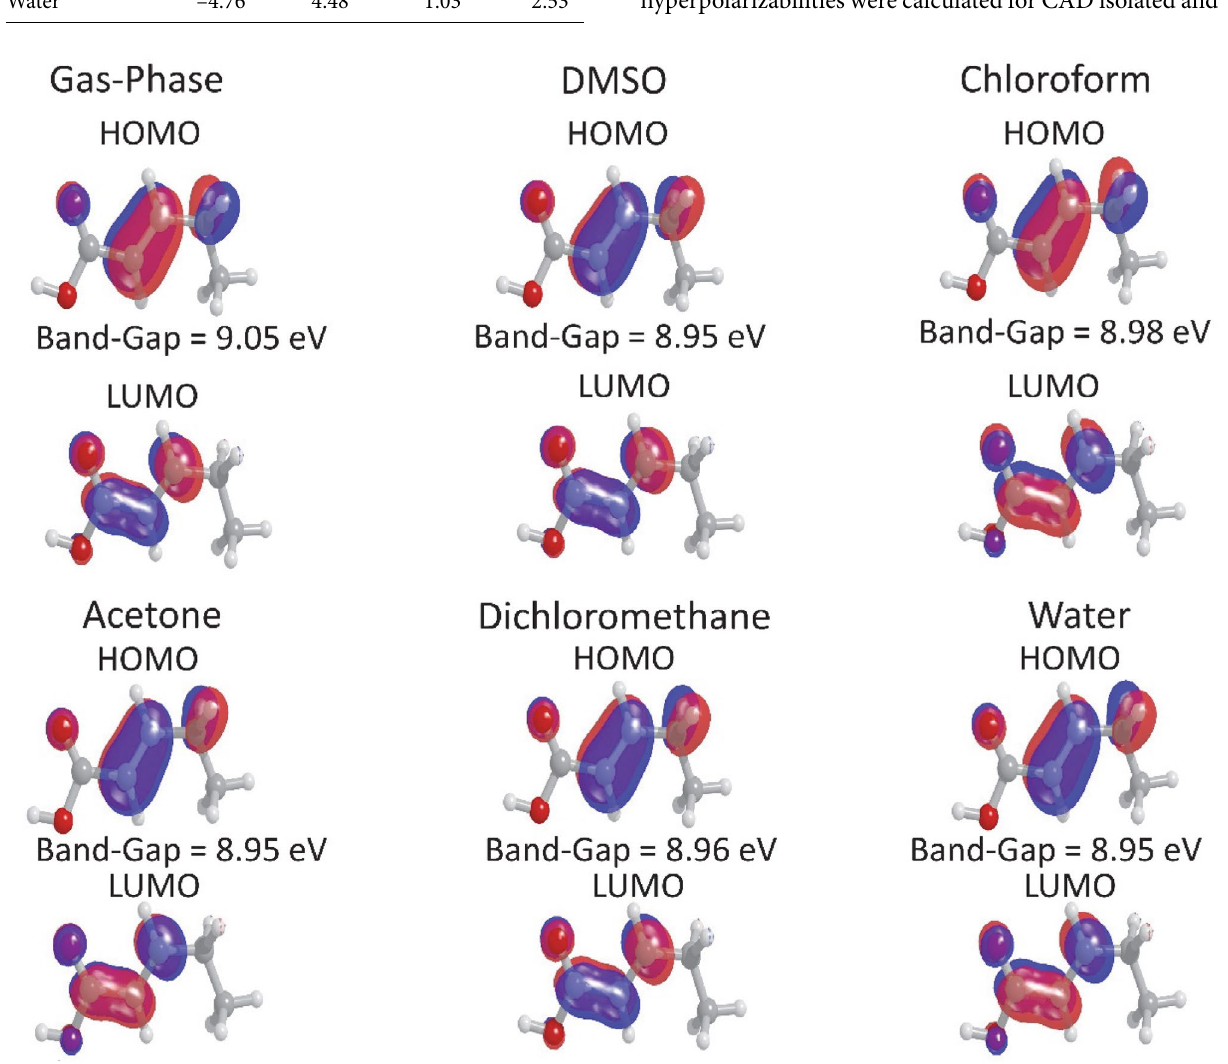
Figure 12: The HOMO-LUMO frontier orbital for the compound C 5 H 8 O 2 in different solvent